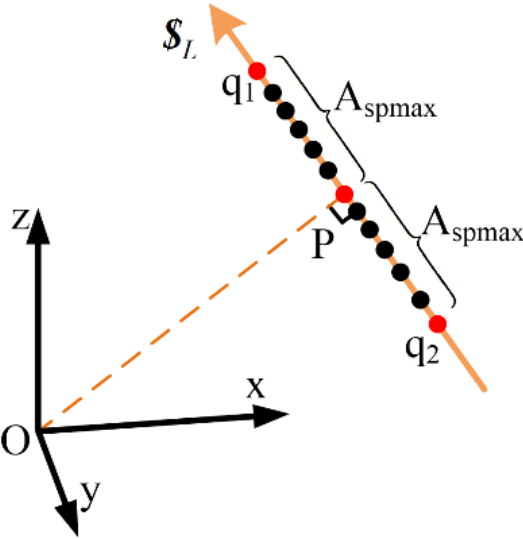
Figure 4. The distribution of striction points on a screw axis.